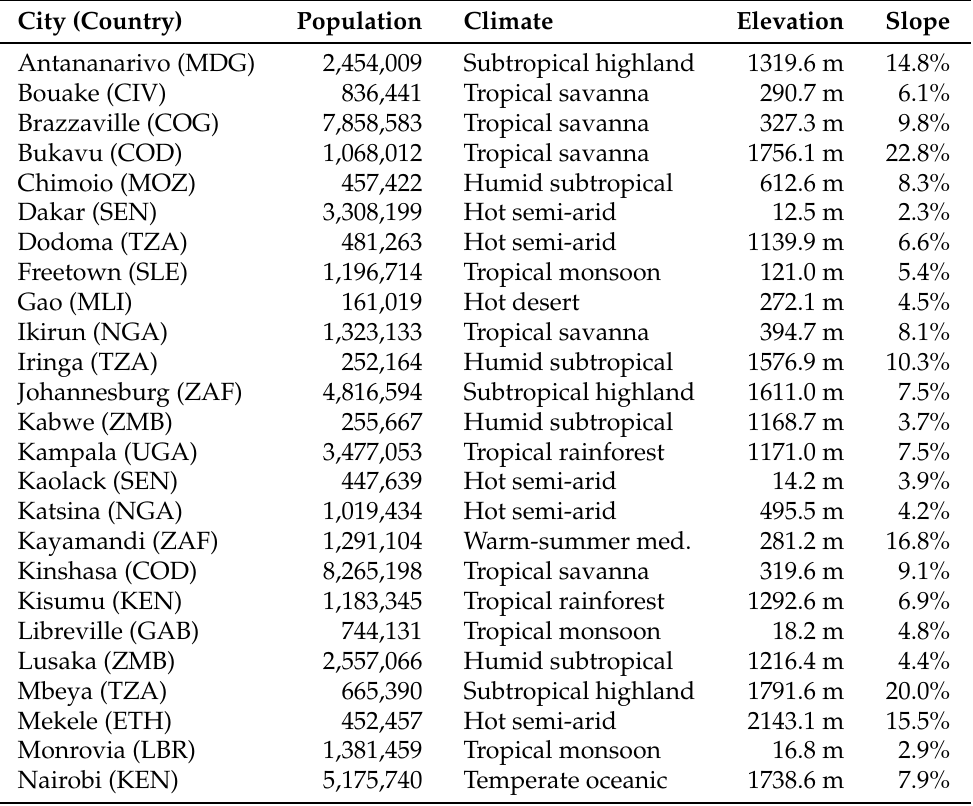
Table 1. Climate, topography and population estimates of each case study. Values are aggregated for the area of interest of each case study, i.e., the 20 km rectangular buffer around the city centers. Climate data are derived from the Koppen–Geiger classification [49]. Mean slope and elevation are computed from the Shuttle Radar Topographic Mission (SRTM) 30 m [50]. Population is estimated using the AfriPop/WorldPop dataset